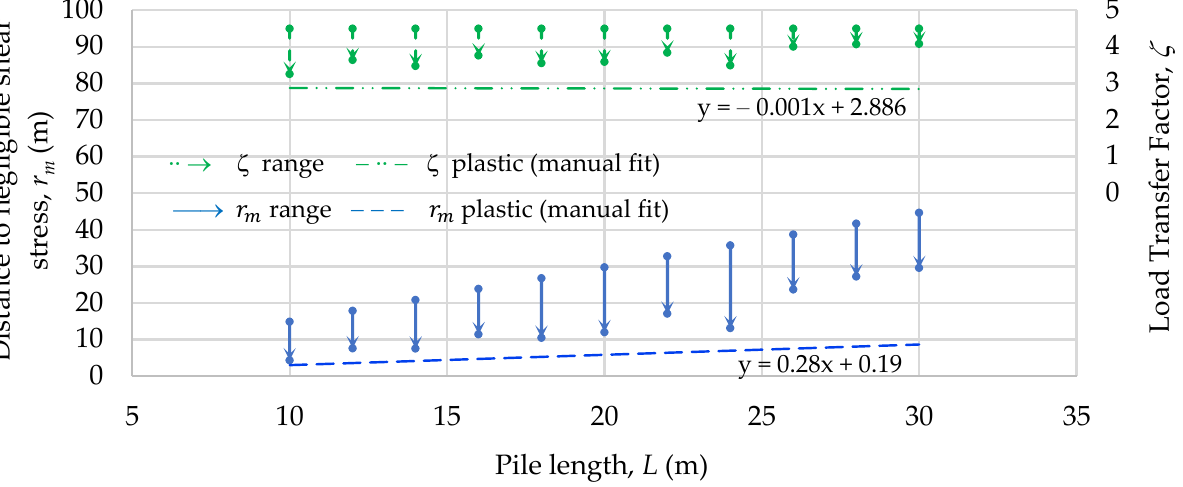
𝐿 = 60 and soil = 60 and r 𝑟